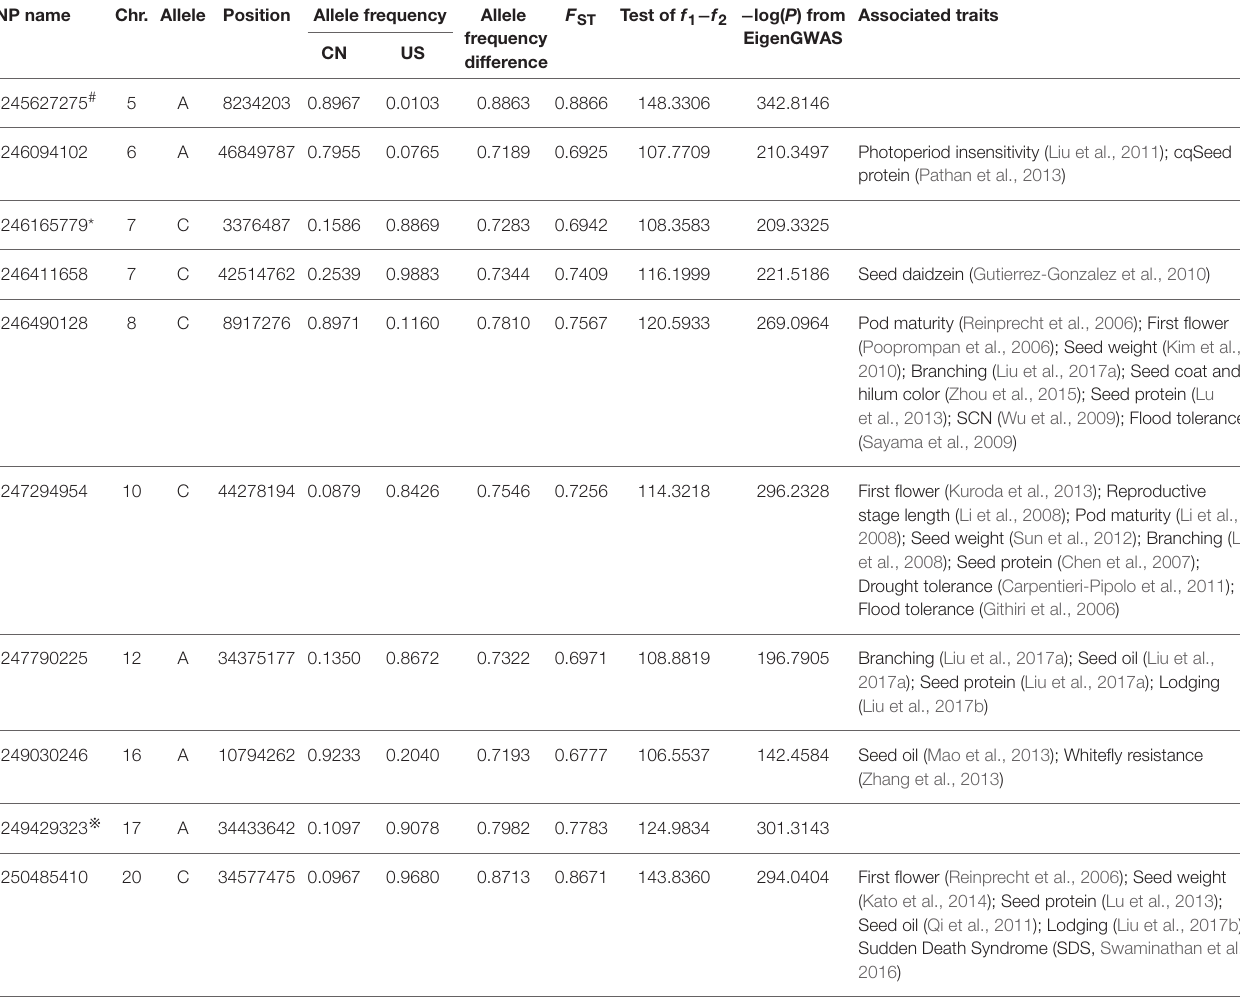
TABLE 2 | The top 10 SNPs with significantly ( P < 10 − 6 ) different allele frequencies between China and the US